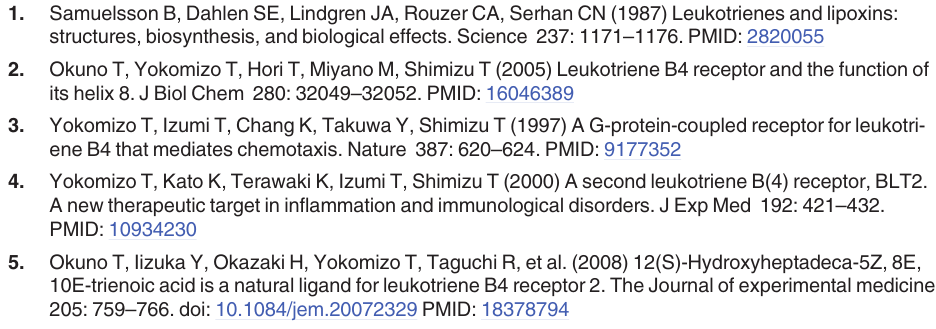
S1 Fig. Specificity of blt1 and lta4h morpholinos. (A) 5 ’ sequence of EGFP mRNA designed to evaluate the function of the blt1 MO. The underline indicates the blt1 MO target sequence, the start codon is highlighted in blue, and the beginning of the open reading frame (ORF) of EGFP is highlighted in green. (B) Representative images of the effects of the blt1 MO on the ex- pression of control EGFP and blt1 MO-EGFP. Translation of EGFP mRNA containing the blt1 MO target sequence is blocked by the blt1 MO. Control EGFP is not blocked by the blt1 MO. Embryos were injected with a mix of mRNA (250 pg) and MO (2.5 ng) at the one cell stage. EGFP fluorescence and bright-field (BF) images were taken at 7 hpf. (C) 5 ’ sequence of EGFP mRNA designed to evaluate the function of the lta4h MO. The underline indicates the lta4h MO target sequence, the start codon is highlighted in blue, and the beginning of the ORF of EGFP is highlighted in green. (D) Representative images of the effects of the lta4h MO on the expression of the lta4h MO-EGFP. Translation of EGFP mRNA containing the lta4h MO tar- get sequence is blocked by the lta4h MO but not by a control MO. Embryos were injected with a mix of mRNA (250 pg) and MO (2.5 ng) at the one cell stage. EGFP fluorescence and BF im- ages were taken at 6.5